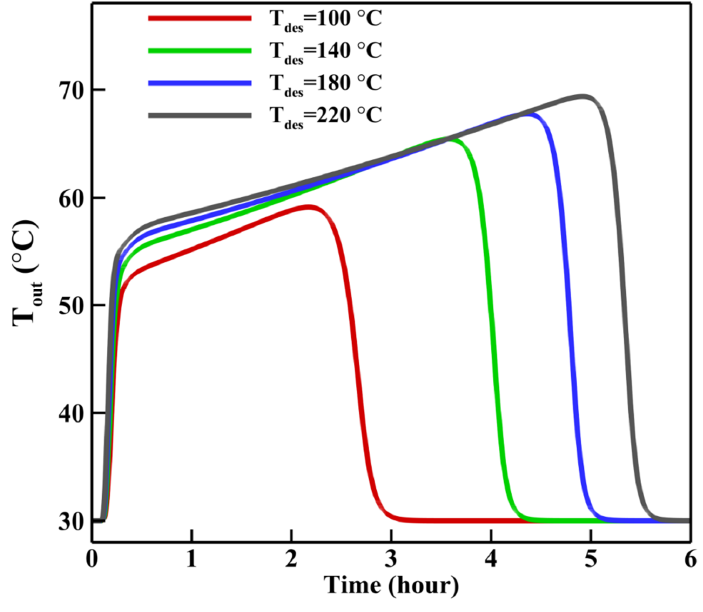
Figure 4. The outlet temperature of the reactor for different desorption temperatures